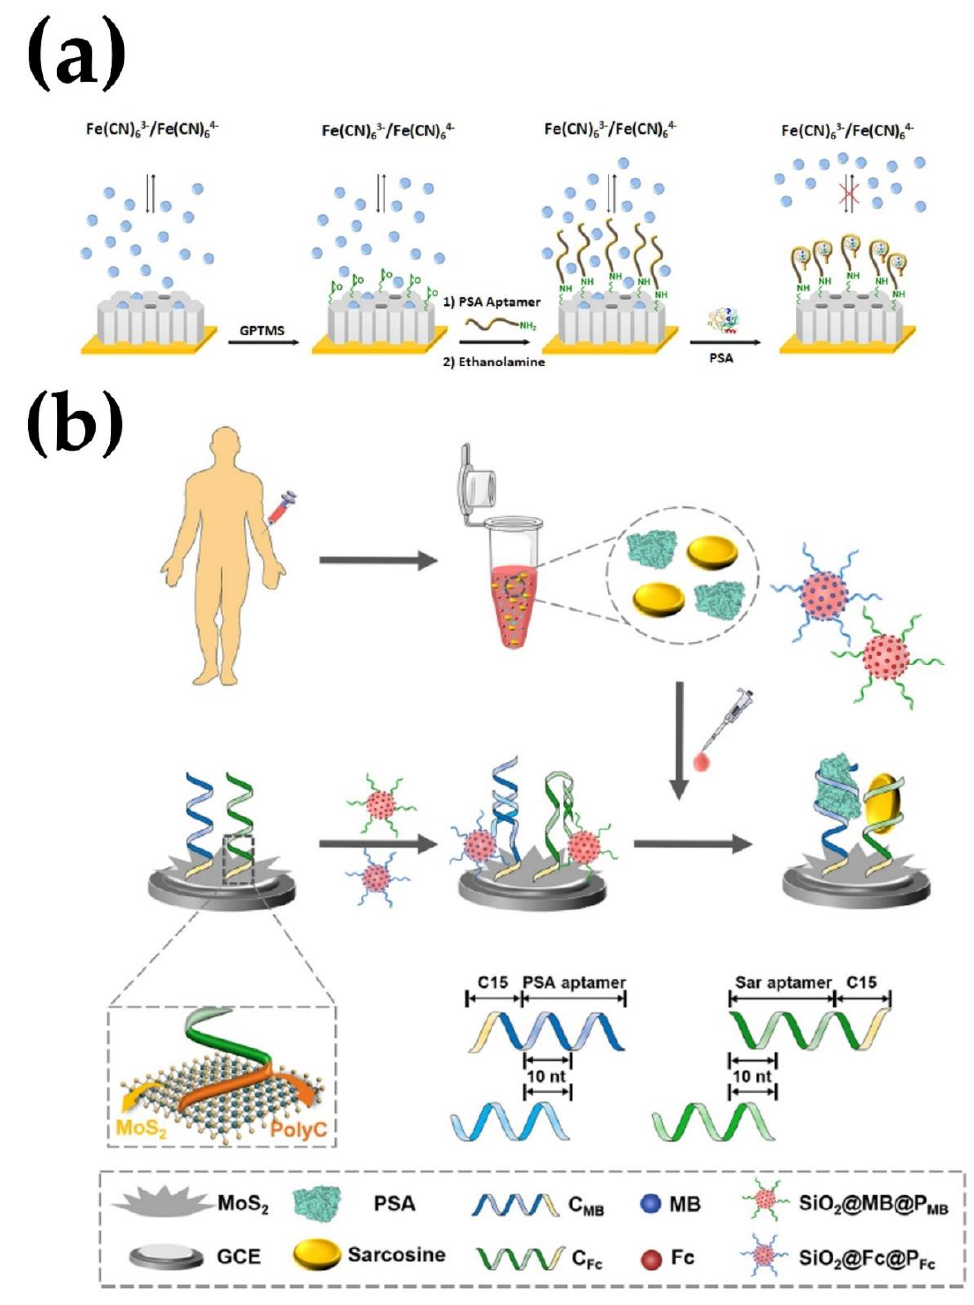
Figure 6. Schematic presentation of electrochemical aptasensor for the detection of breast cancer. ( a ) an electrochemical “bio-gate” mesoporous silica nanochannels aptasensor for the detection of PSA. ( b ) An electrochemical biosensor based on a flower-like MoS2 nanostructure for the detection of PSA and sarcosine. Reprinted with permission from Refs. [93,95]. Copyright 2018, 2022 Elsevier.